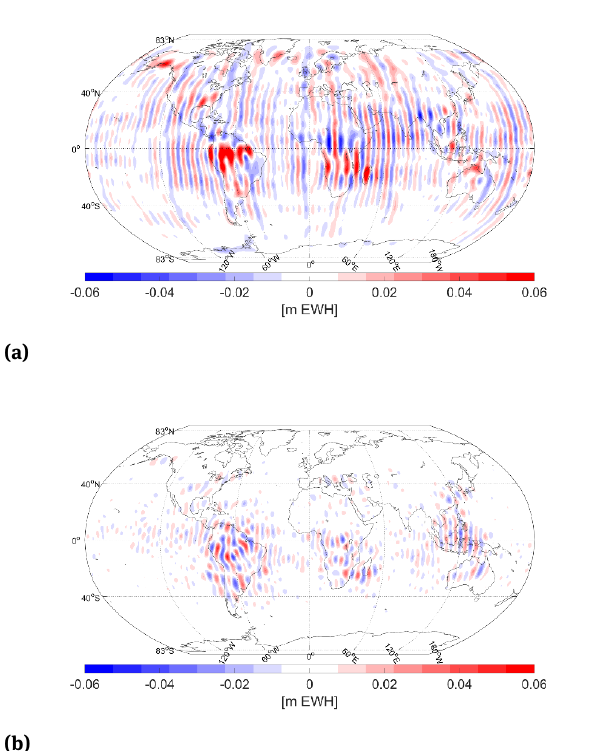
Fig. 8. Global grids of EWH [m] up to d/o 50 for GRACE (a) and MO- BILE minimum configuration